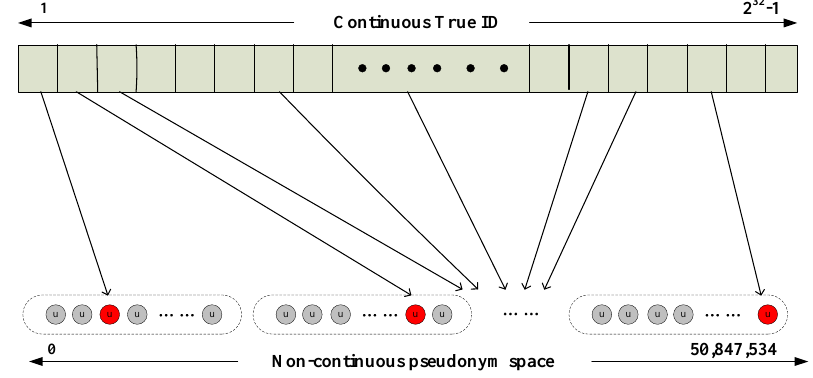
Figure 2. Non- consecutive pseudonym single mapping.